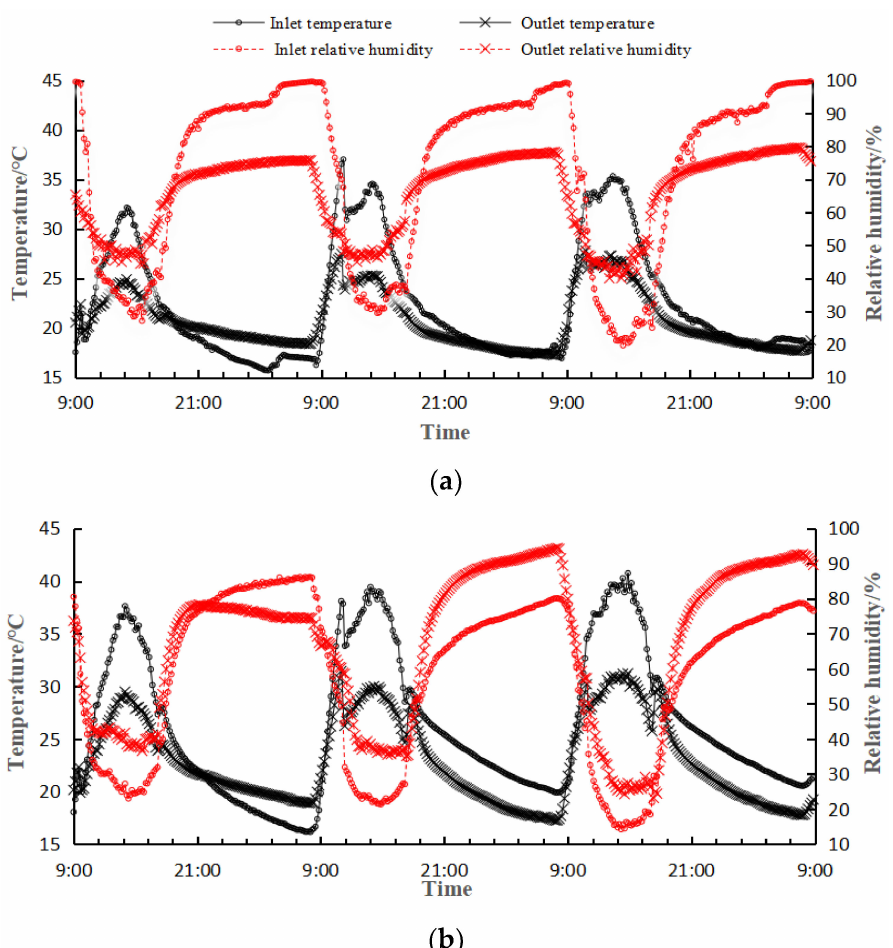
Figure 6. Temperature and humidity changes on a typical sunny day (19 February 2021 9:00–22 February 2021 9:00). ( a ) SG; ( b )